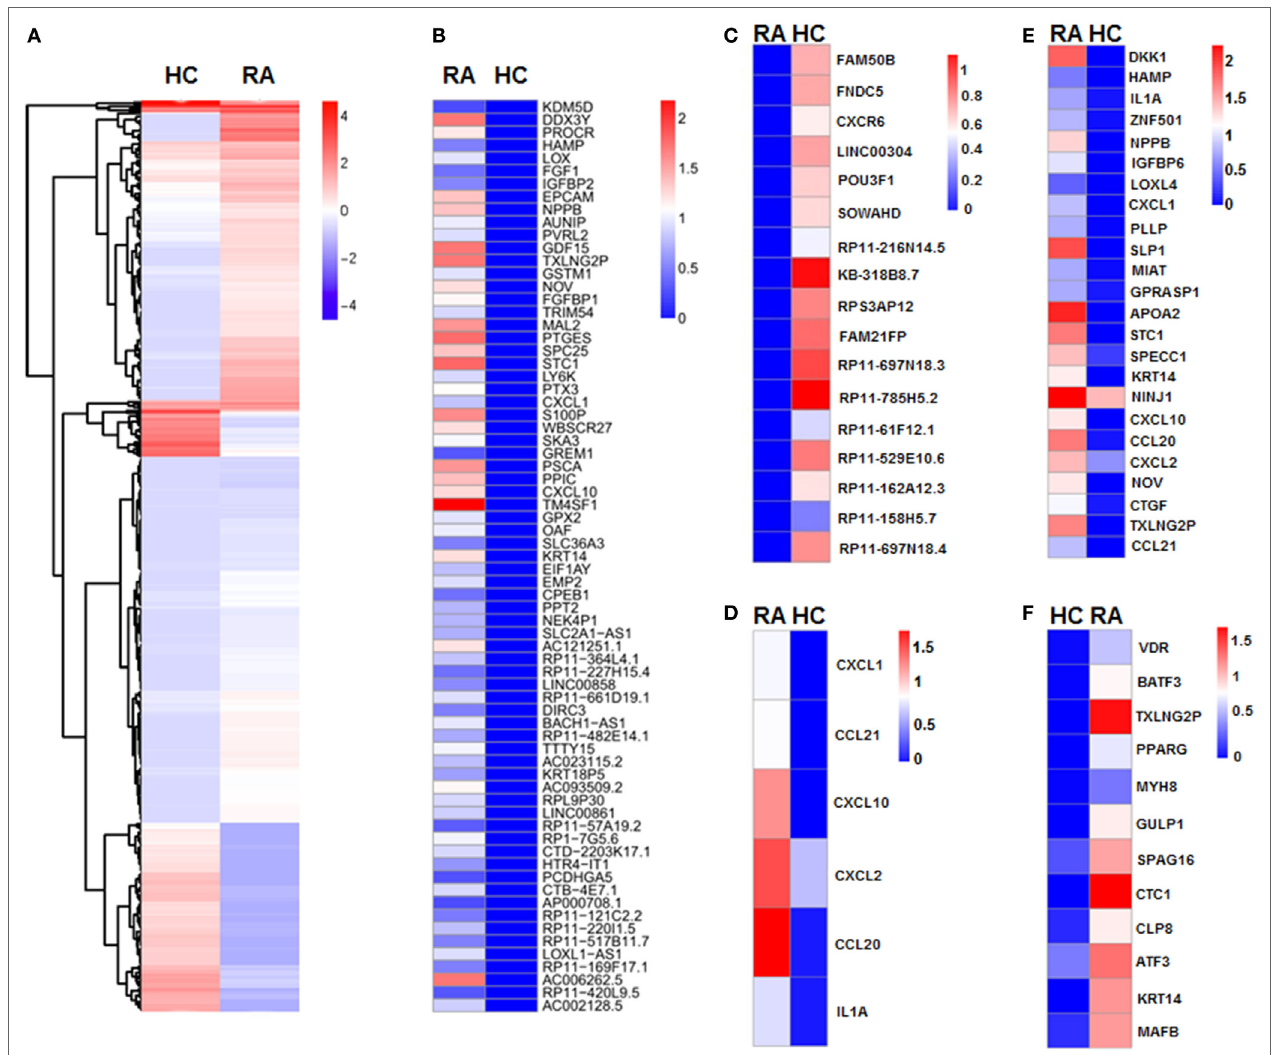
FigUre 5 | Single cell sequencing of CD27 + IgD + B cells in healthy controls and rheumatoid arthritis (RA) patients. (a) Unsupervised clustering analysis of differentially expressed genes of CD27 + IgD + B cells in RA and healthy individuals based on single cell sequencing data. Blue and red represent low and high expression levels, respectively. (B) Heat-map of clustering analysis of 71 genes uniquely expressed in RA, but not in healthy control CD27 + IgD + B cells. (c) Heat-map of clustering analysis of 17 genes uniquely expressed in healthy control, but not in RA CD27 + IgD + B cells. (D) Gene ontology (GO) analysis of differentially expressed genes with regards to chemokine activity and chemokine receptor binding, cytokine activity and cytokine receptor binding as well as immune response. (e,F) GO analysis of differentially expressed genes with regards to extracellular region (e) and transcriptional factors (F) ,